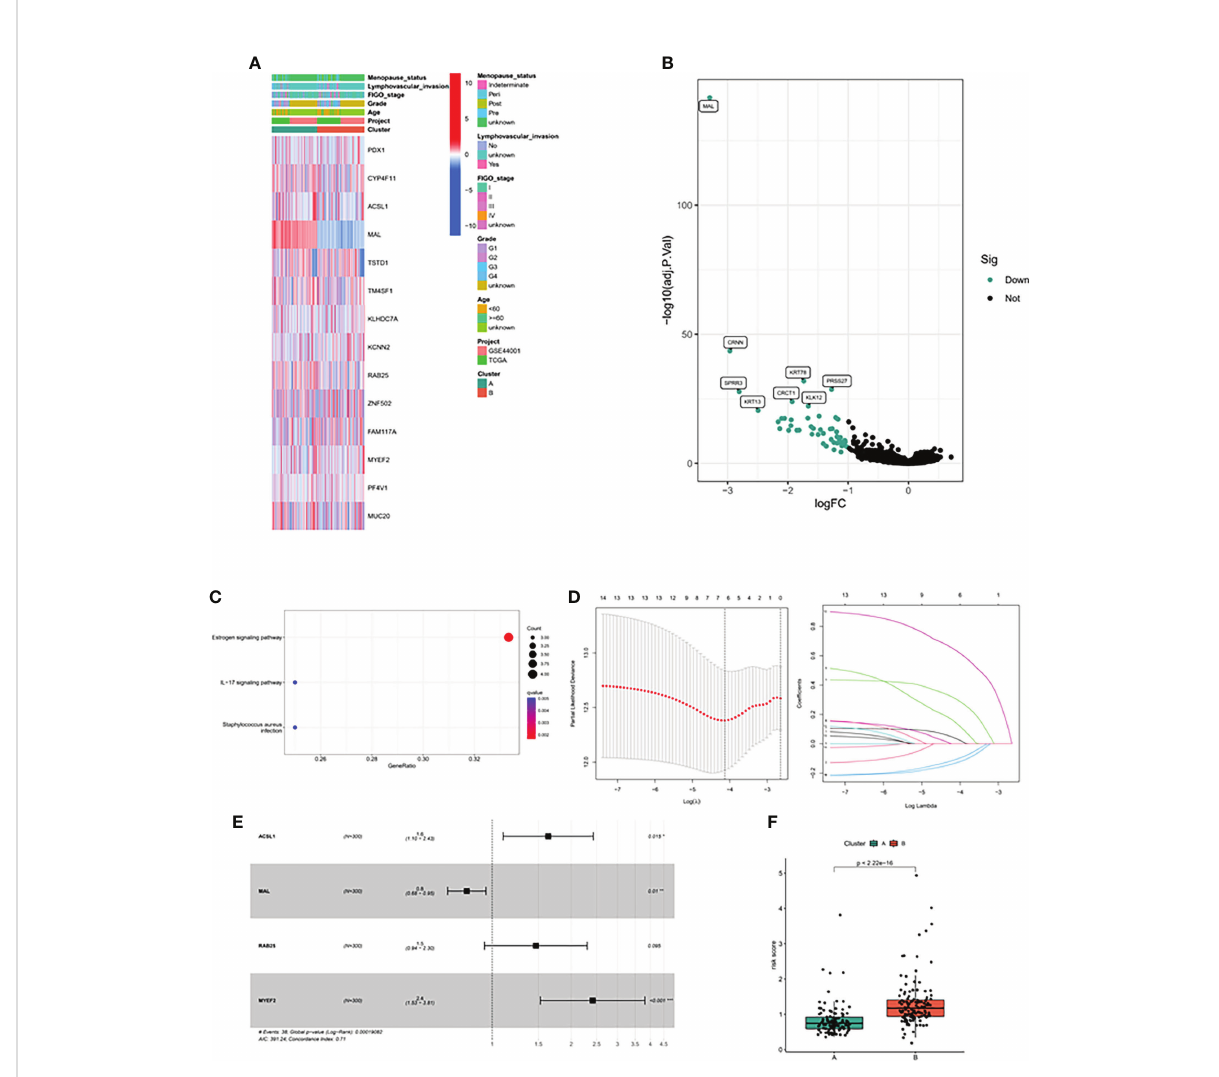
FIGURE 4 Methylation driven associated predictive model. (A) Heatmap of methylation driver genes among different clinical subtypes and methylation driven related subtypes. (B) The volcano map showed the differentially expressed genes between the two subtypes. (C) GO analysis of differentially expressed genes. (D) LASSO algorithm was used to reduce the correlation between methylation driven genes. (E) The Forest map displayed the hazard ratios of the 4 target genes. (F) Risk score between the two